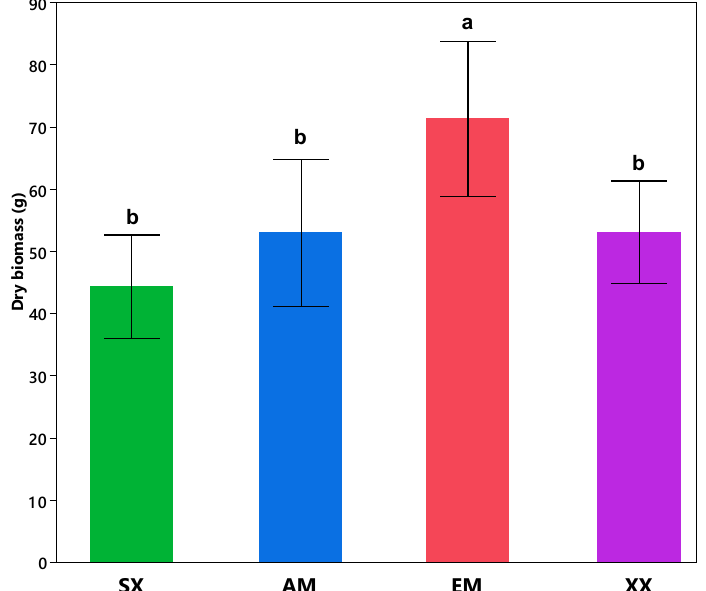
Figure 1. Mean dry aerial biomass production of Salix miyabeana SX67 inoculated with R. irregularis (AM), S. brunnea (EM), both fungi (XX), or non-inoculated (SX), illustrates that only the EM treatment significantly increased biomass. Measures were taken from five plants in each plot, at the end of the second growing season (October 2016) after drying at 60 degrees C. Column values were obtained by calculating the average of five samples per treatment in each of the five blocks, then obtaining the mean value across all blocks for each treatment. Error bars represent standard error. Treatments not sharing a letter are significantly different.